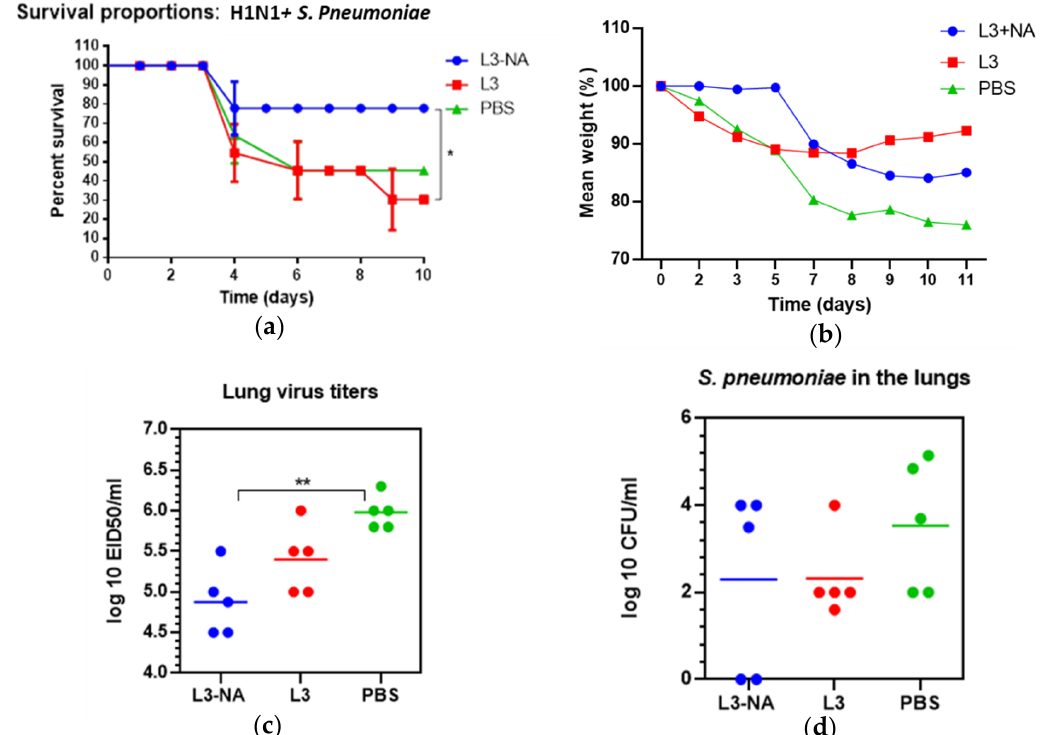
Figure 10. Protection against A/South Africa/3626/13(H1N1)pdm09 influenza infection followed by S. pneumoniae super- infection. On day 10, after the end of the third feeding, the mice were intranasally infected with one MLD 50 of A/South Africa/3626/13(H1N1)pdm09 influenza virus; infection with S. pneumoniae serotype 3 (5 × 10 4 CFU) was performed 24 h after primary influenza infection. ( a ) Survival proportions ( n = 10). Log-rank (Mantel–Cox) test, * p < 0.05 compared to L3 group; ( b ) body weigh dynamics; ( c ) infectious virus isolation from the lungs on day 5 following primary influenza infection ( n = 5), ** p < 0.01; ( d ) S. pneumoniae in the lungs on 18 h after infection.